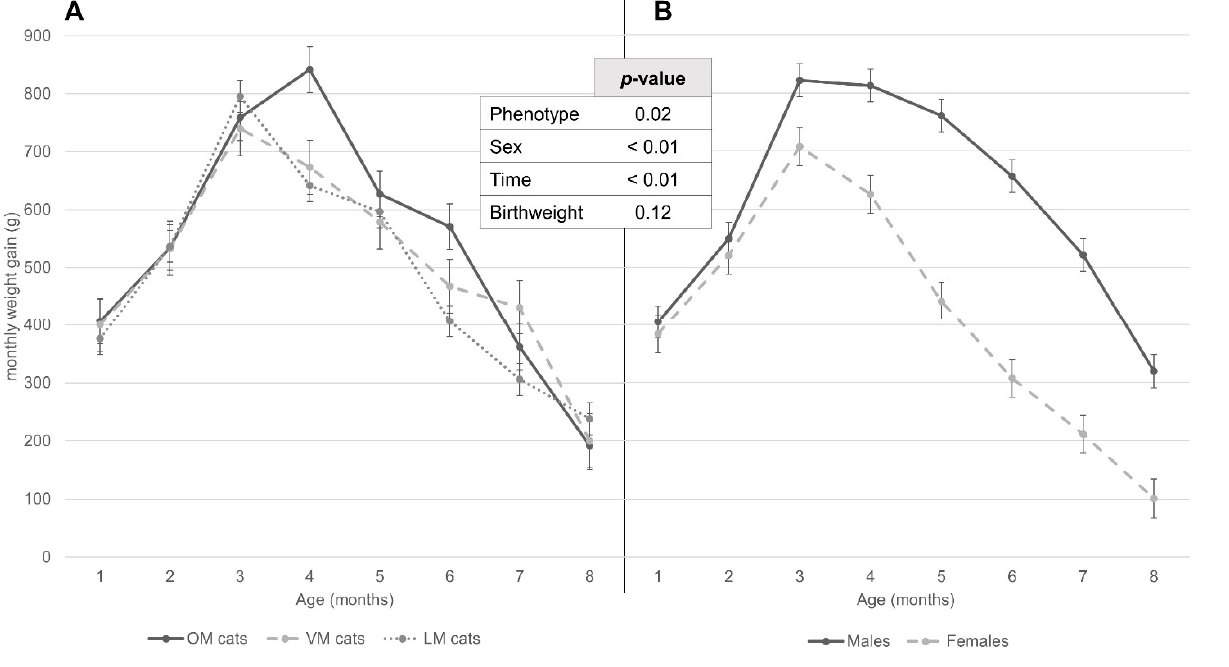
Figure 4. Least square means of monthly weight gain from first to eight months of age, according to ( A ) maternal phenotype and ( B ) sex (data from repeated measures mixed model). Standard errors are depicted with brackets per month, for each group. p -values for each independent variable used in the repeated measures mixed model are specified in the central table. Both ( A , B ) are depicted according to the same scale. OM = maternal BCS always ≥ 6, VM = maternal BCS differing between < and ≥ 6, LM = maternal BCS always <6. Time significantly interacted with phenotype and sex (both p < 0.01).